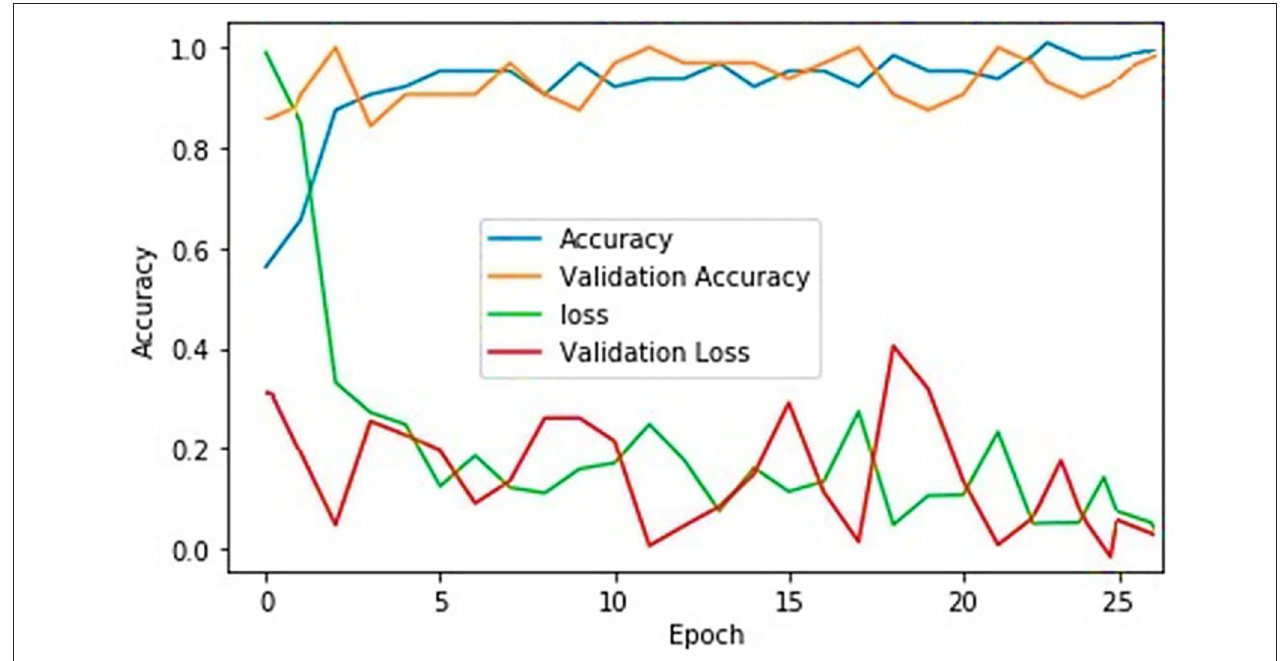
FIGURE 3 | Performance results of the suggested hybrid deep learning technique.